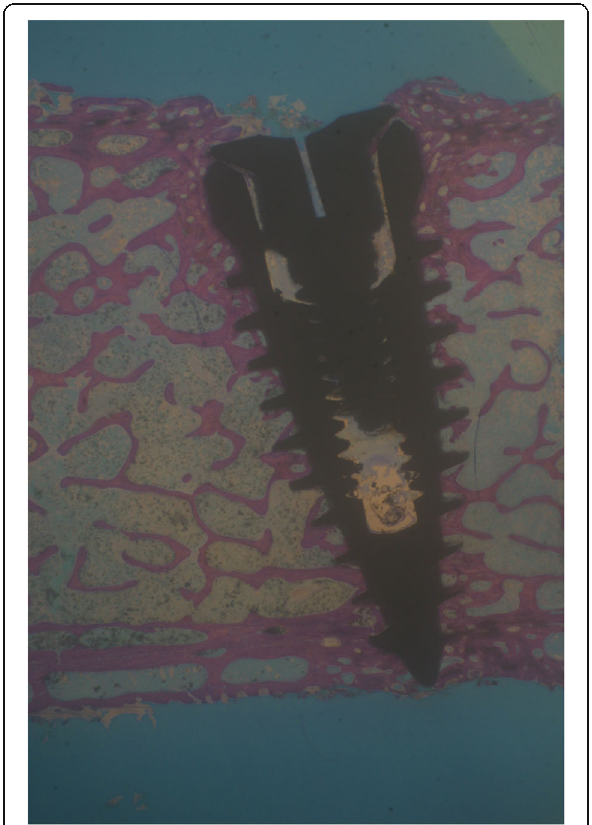
Figure 1 Test group. The implant achieved a high osseointegration degree. The newly formed bone appeared well interconnected with the pre-existing trabeculae. The “ corticalization ” phenomenon is evident: the bone appears densified around a titanium implant (magnification × 8 — toluidine